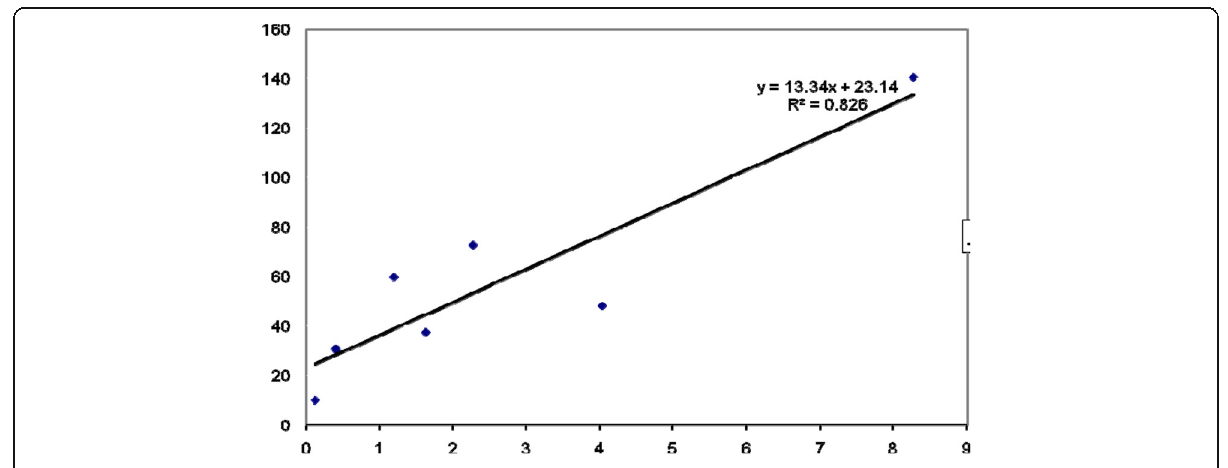
Fig. 2 LD50 determination curve of BPF (23.14 mg/kg